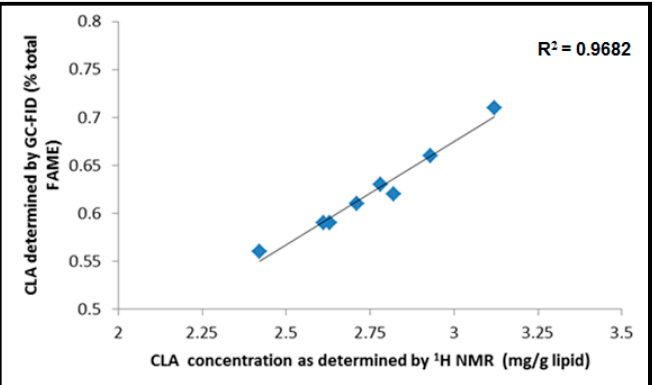
Figure 2. Correlation between total concentrations of CLA as determined by 1 H NMR and GC-FID.